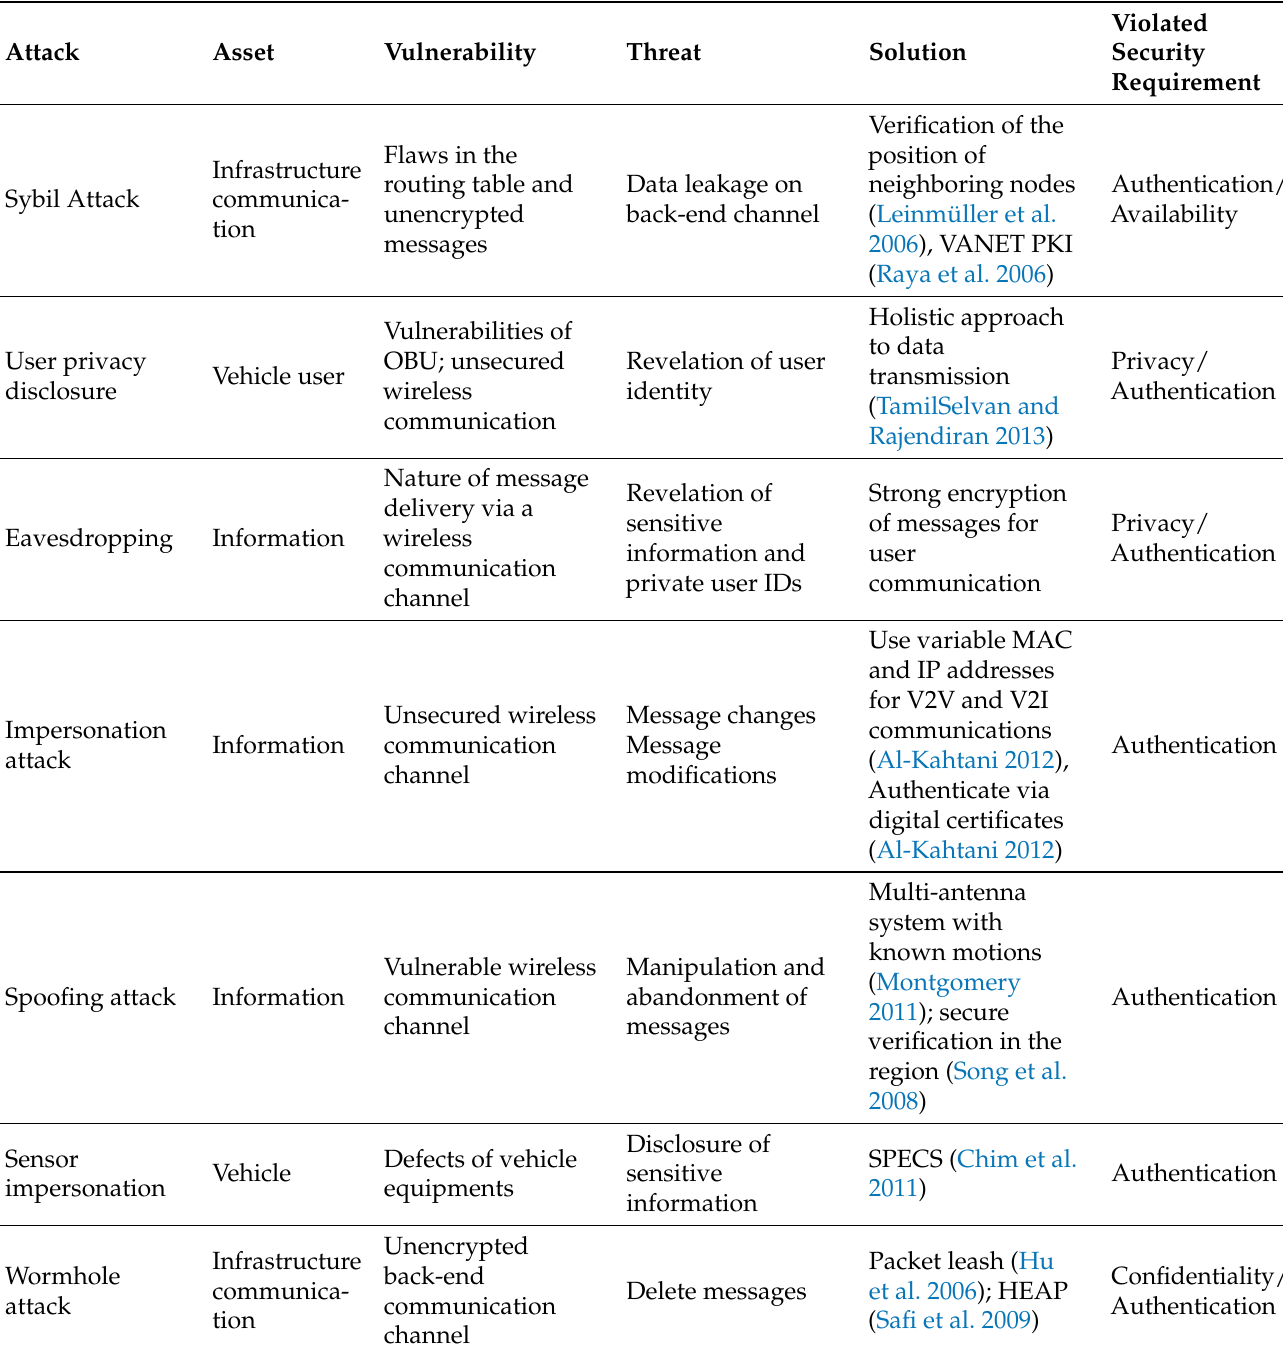
Table 1. Attacks targeting